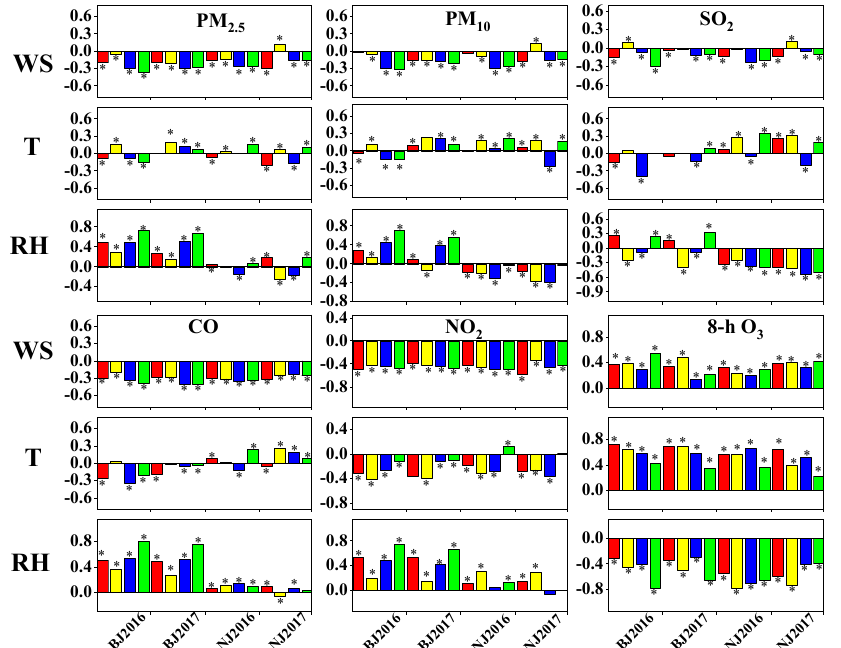
Figure 9. Correlations between six criteria air pollutants and meteorological factors: surface wind scale ( WS ), ambient temperature ( T ), and relative humidity ( RH ). Red, yellow, blue, and green represent spring, summer, fall, and winter, respectively. * indicates the significant level at 95%. The relationships between air pollutants and RH were complicated. In Beijing, PM 2.5 , PM 10 , SO 2 , CO, and NO 2 concentrations were positively correlated with RH in most cases, especially in winter.